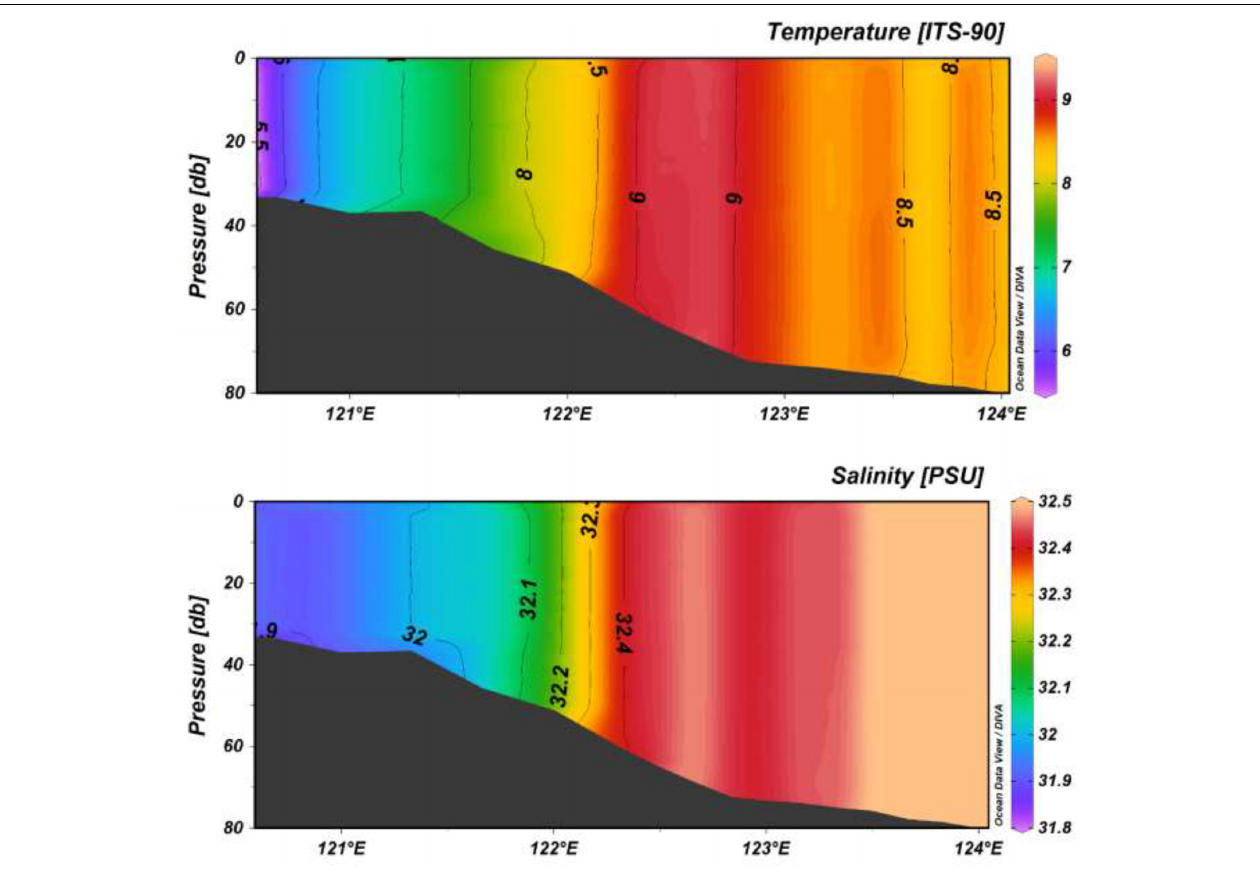
FIGURE 2 | Temperature and salinity distributions in the 35 ◦ N section of the southern Yellow Sea in January 2009 (the section was measured between January 28 and January 29, 2010).